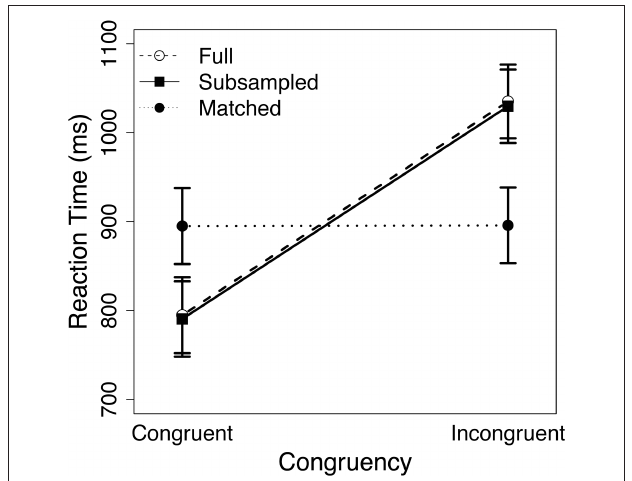
FIguRe 3 | Mean reaction time (RT) for congruent and incongruent trials in the full data set (open circles), the RT-subsampled data set (filled squares), and the RT-matched data set (filled circles). Errors bars denote ± 1 SE of the mean.